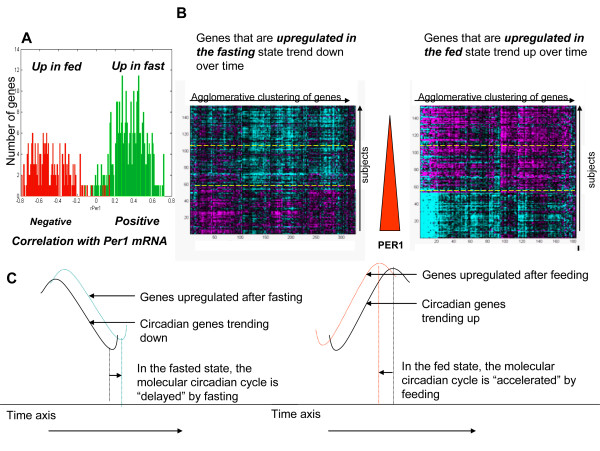
Genes with expression levels that were changed by fasting and feeding were also diurnally regulated. A) In general, genes in the fasting signature were positively correlated with PER1 whereas genes in the feeding signature were negatively correlated with PER1. B) These two heatmaps show the trend of these signatures throughout the day. Morning, afternoon and evenings are separated by yellow dotted lines. The color scale of the heatmaps is the same as in Figure 2A. A solid red arrow depicts PER1 mRNA levels declining over time. C) The proposed phase differences produced by fasting and feeding.